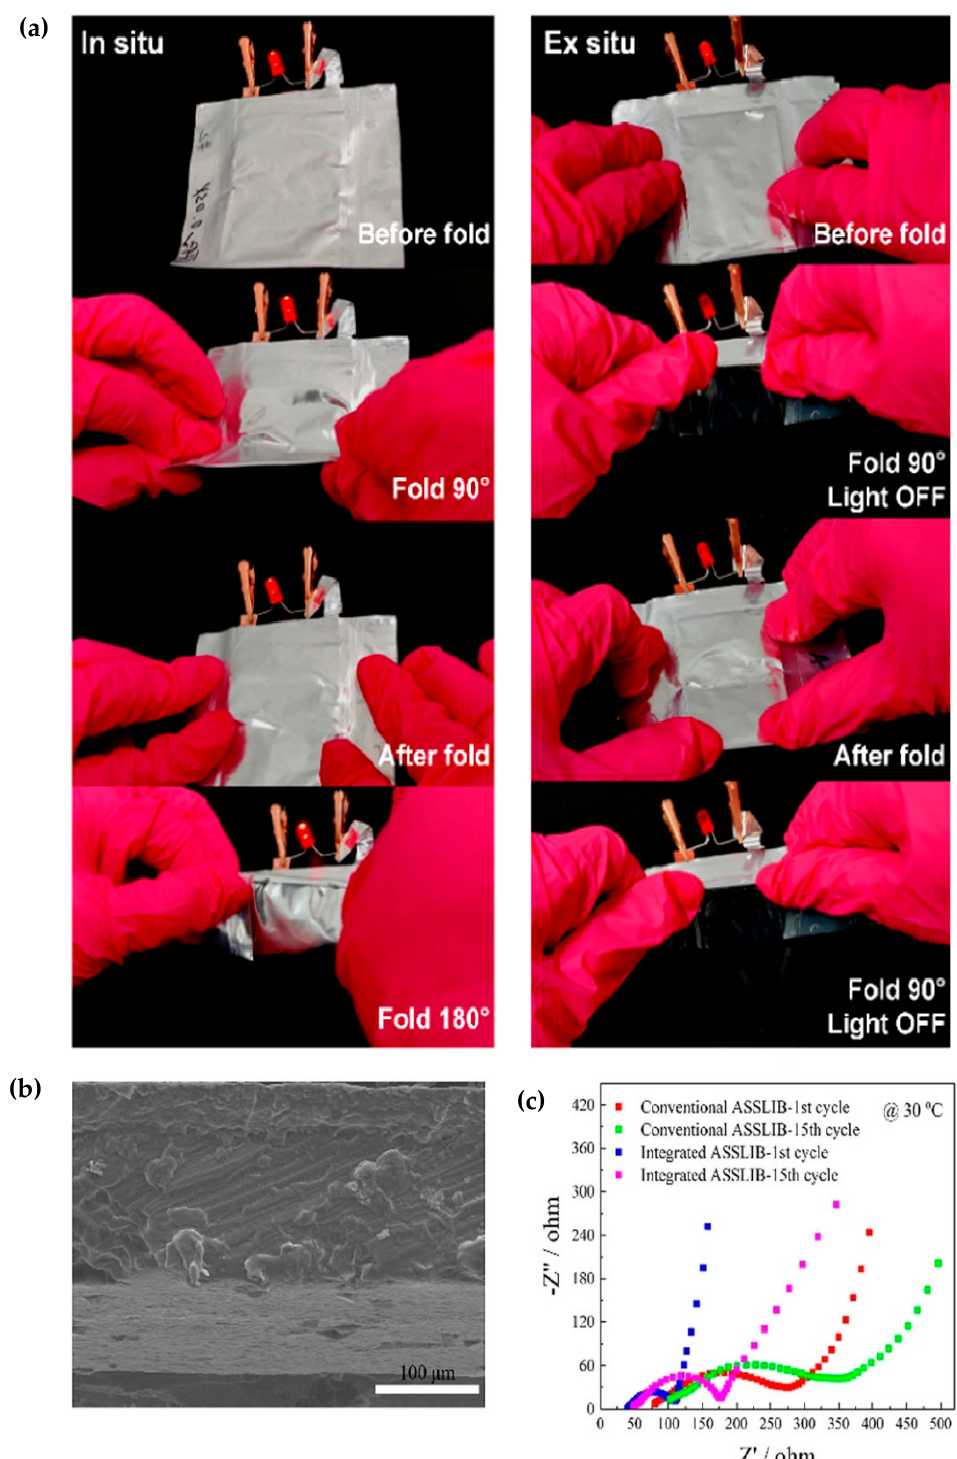
Figure 8. ( a ) Demonstration of the in situ and ex situ pouch-cell-powered LED during folding deformation [102]. Copyright ® 2022, American Chemical Society; ( b ) cross-sectional SEM image of interface between electrode and electrolyte; and ( c ) AC impedance of conventional and integrated ASSLIBs after first and fifteen cycle. Reprinted/adapted with permission from Ref. [103]. Copyright ® 2020, John Wiley & Sons, Inc.